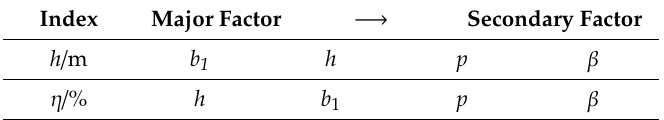
Table 13. The order of influence of the gap geometry parameters on pump performance at 1.0 Q .